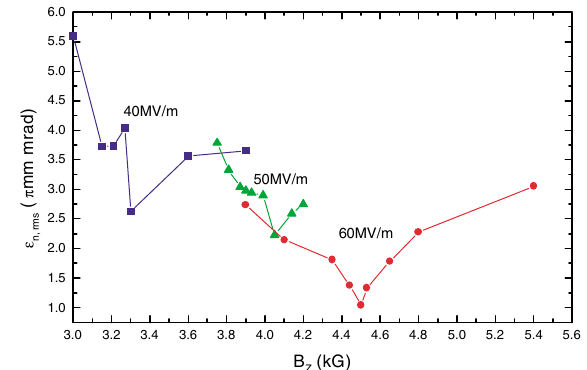
FIG. 4. (Color) Normalized transverse rms emittance variation with magnetic field for different electric field gradients.